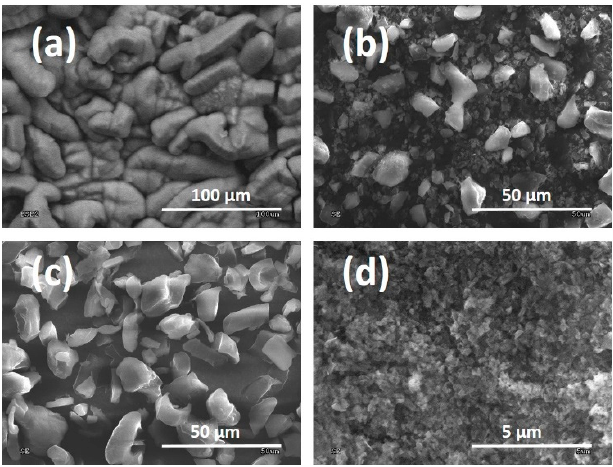
Figure 4. SEM pictures of powders: ( a ) produced using the chemical vapour deposition (CVD) method; ( b ) dry-milled; ( c ) milled in water; ( d ) milled in methanol.